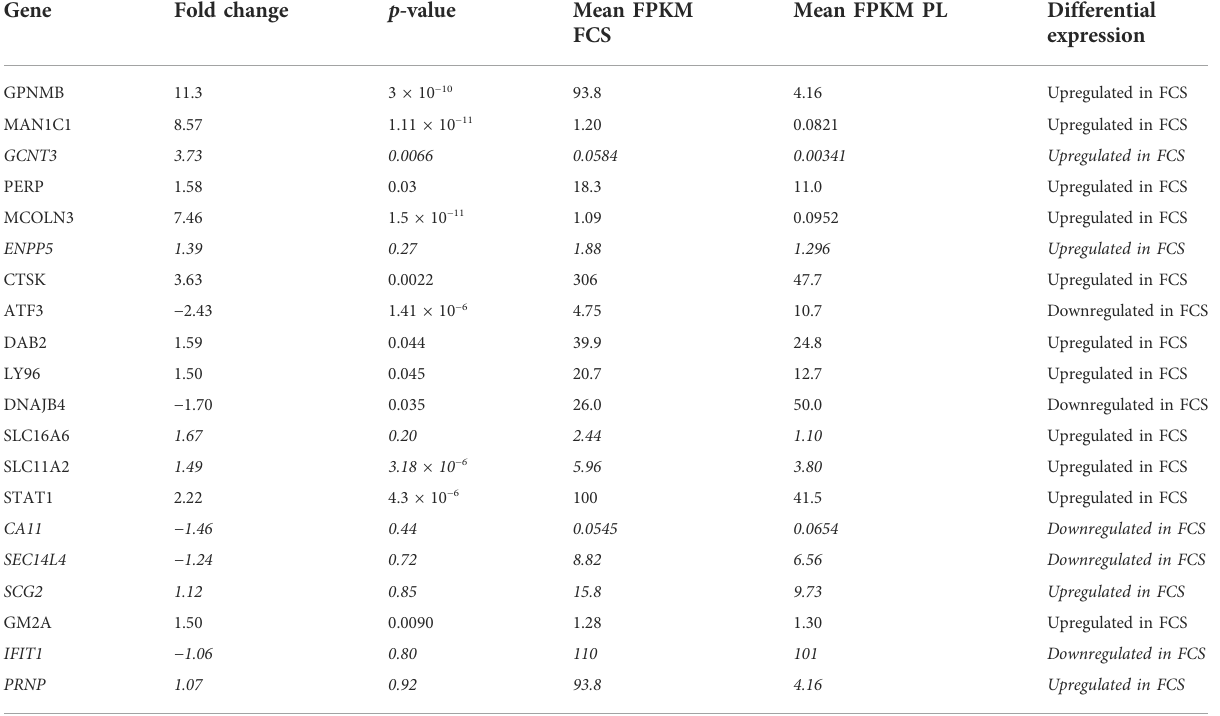
TABLE 3 overview of differential expression of genes reported to be upregulated in senescent MSC passages. Genes are designated by their gene name. Fold change, p -value and FPKM for each gene are detailed in the columns. FPKM will be highest in the condition where the gene is upregulated. The direction of differential expression is shown in the last column. Genes that are considered not to be signi fi cantly up- or downregulated ( p > 0.05 and/or FPKM < 0.3) are marked in italic. (Gene list from Wagner et al.,